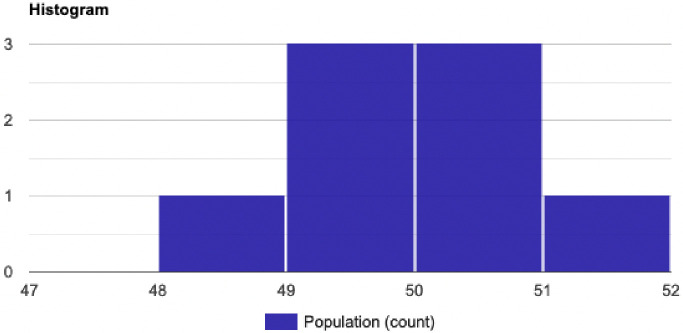
The probability density function for cost function g(X).